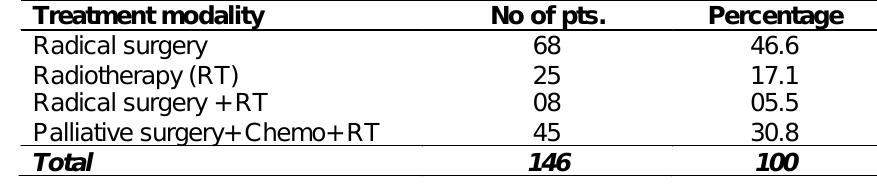
Table III : Overall treatment modality of head and neck malignancies Treatment modality No of pts.